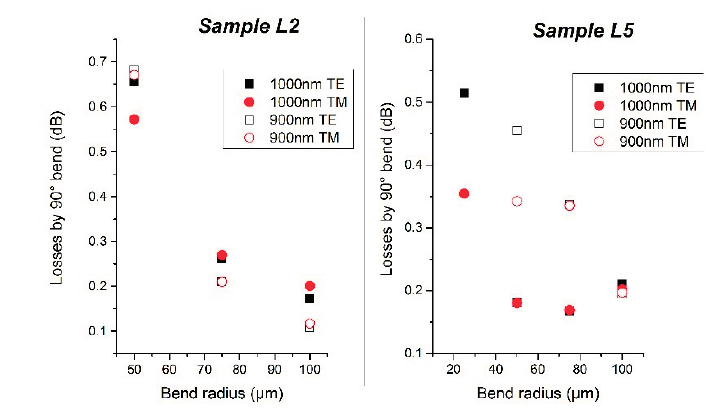
Figure 3. ( Left ) Bending losses of sample L2; ( Right ) Bending losses of sample